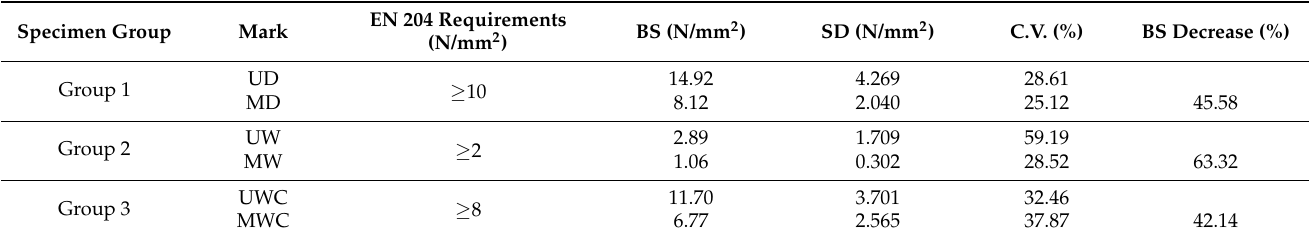
Table 5. Average bond strength (BS), standard deviation (SD), coefficient of variation (C.V.), and difference to modified